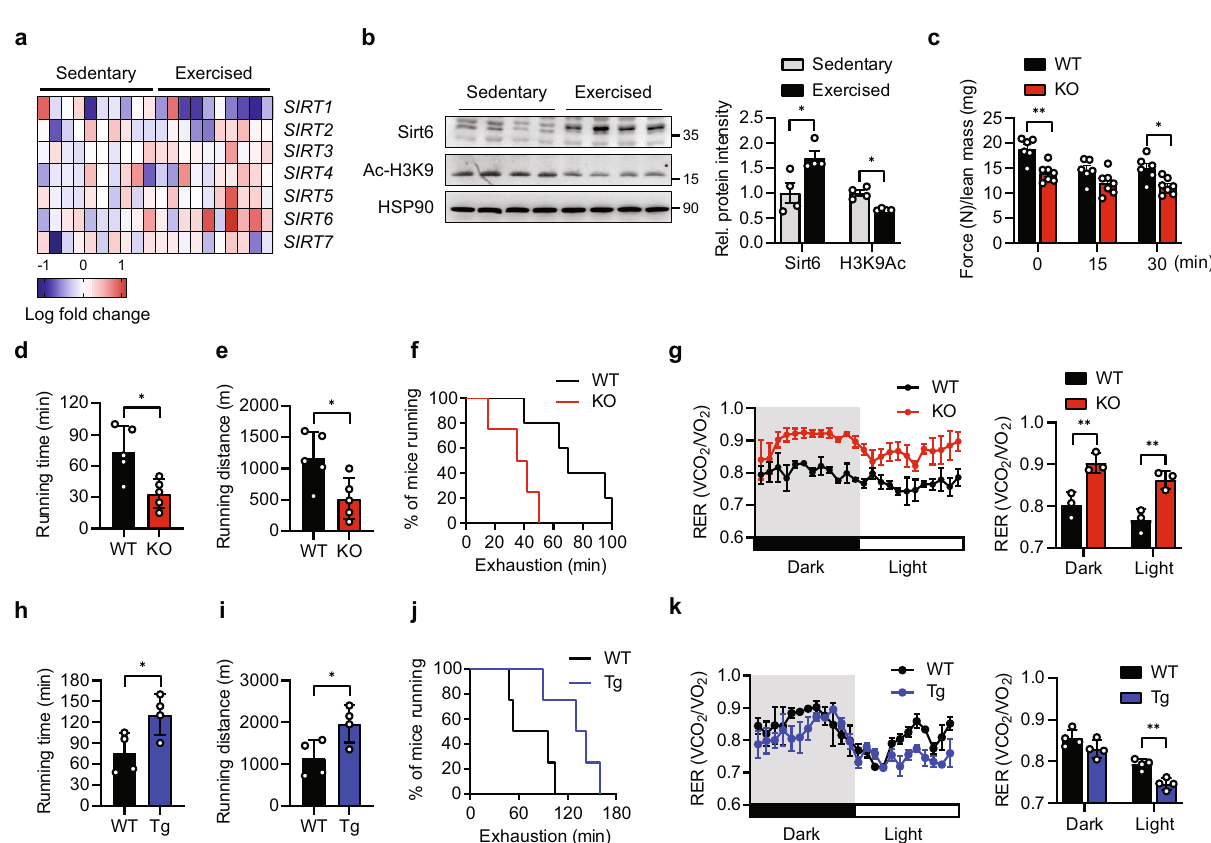
Fig. 1 Alteration of exercise performance in Sirt6 KO and Sirt6 Tg mice. a Heatmap visualizing expression of sirtuin family members in sedentary or exercise-trained human subjects (extracted from GSE9103) ( n = 10). b Representative Western blot images. Expression of Sirt6 in gastrocnemius muscle was compared in sedentary or exercise-trained mice ( n = 4). c Forelimb grip strengths were measured at 15 min intervals and normalized against lean body mass ( n = 6 for WT, n = 7 for KO). d – f , h – j Treadmill endurance performance after four weeks of treadmill exercise training. Running time ( d , h ), distance ( e , i ), and running population plotted against time to exhaustion ( f , j ) in KO or Tg mice, respectively ( n = 5 for ( d – f ), n = 4 for ( h – j )). g , k Twenty-four hour light and dark cycle respiratory exchange ratio (RER) were measured by indirect colorimetry ( n = 3 for ( g ), n = 4 for ( k )). ( d – g ) WT and Sirt6 KO mice, ( h – k ) WT and Sirt6 Tg mice. Values are mean ± SEM. Data are representative of at least three independent experiments. Unpaired two-tailed t test between two groups was conducted for statistical analyses ( b – e , g – i , k ). * p < 0.05 and ** p < 0.01. Source data are provided as a Source Data fi